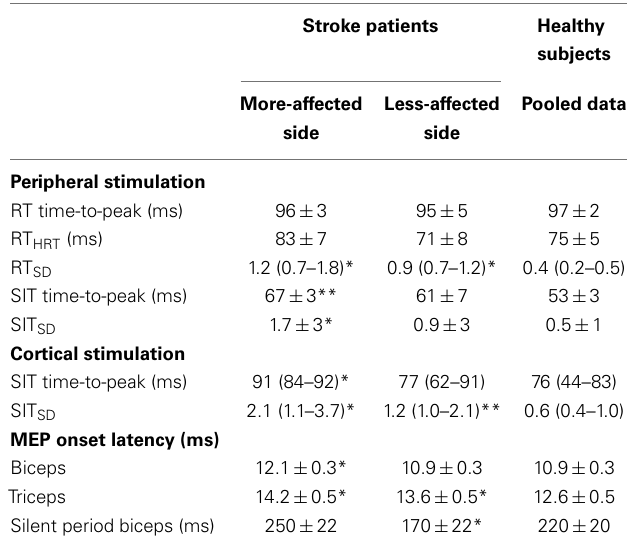
Table 2 | Summary of the resting twitch and superimposed twitch characteristics, MEP onset latency and silent period duration .